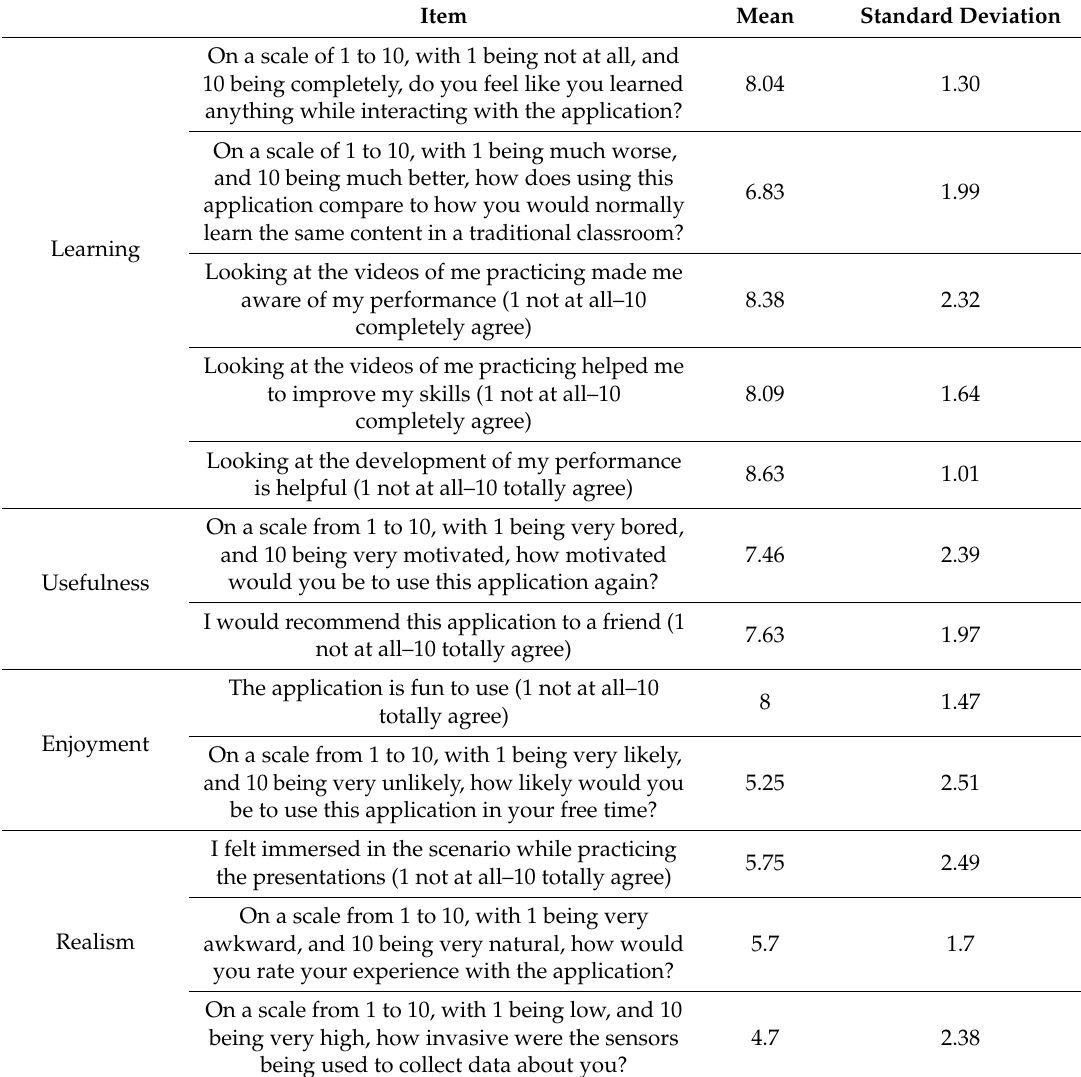
Table 2. Reported results regarding perceived usefulness, enjoyment and